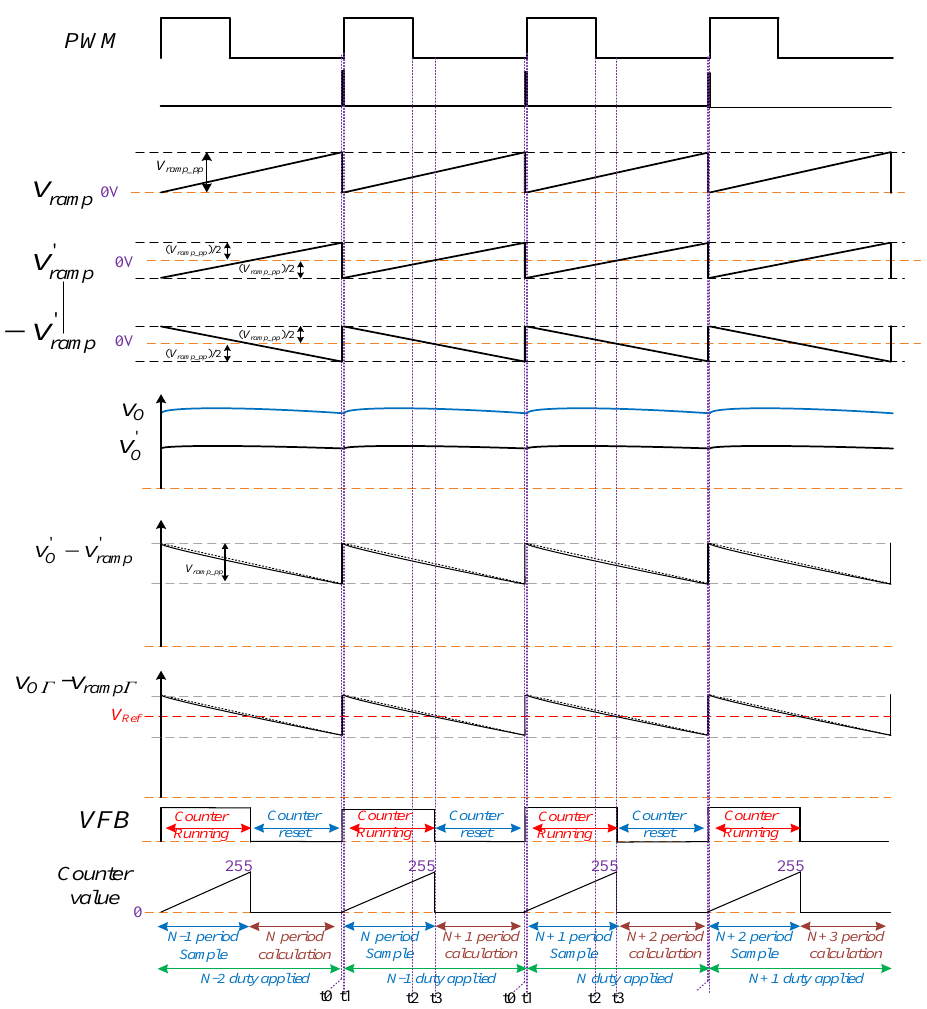
Figure 4. Waveforms relevant to sampling sequence.